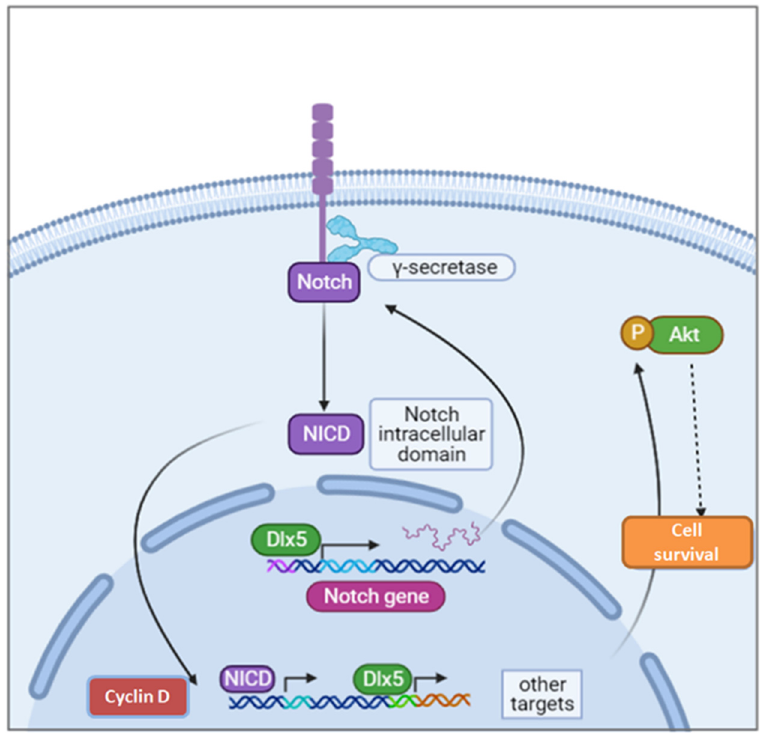
Figure 5. Dlx5 directly induces T-cell lymphoma by activating Notch . A transgenic mouse model expressing Dlx5 gene under the control of a Lck promoter develops a high incidence of T-cell lymphomas with overexpression of Notch genes, Notch1 and Notch3 . These lymphoma cells were very sensitive to γ -secretase inhibitors and exhibited upregulation of Akt signaling and upregulation of Cyclin D.